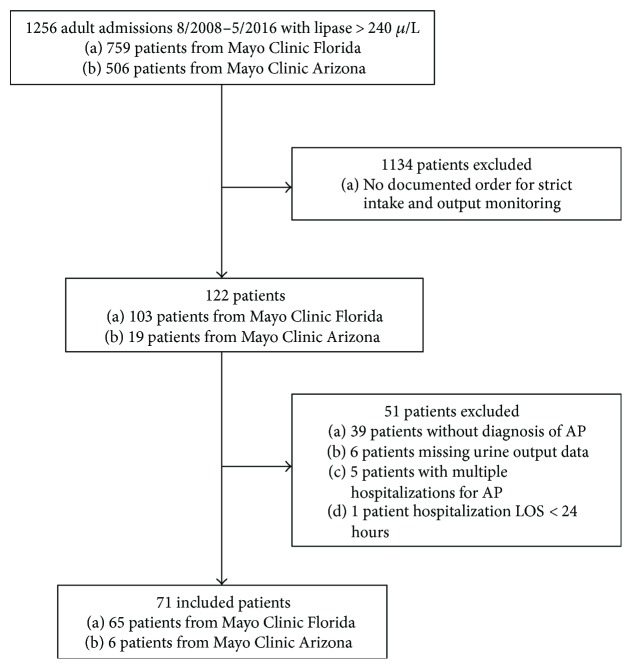
Study inclusion criteria.